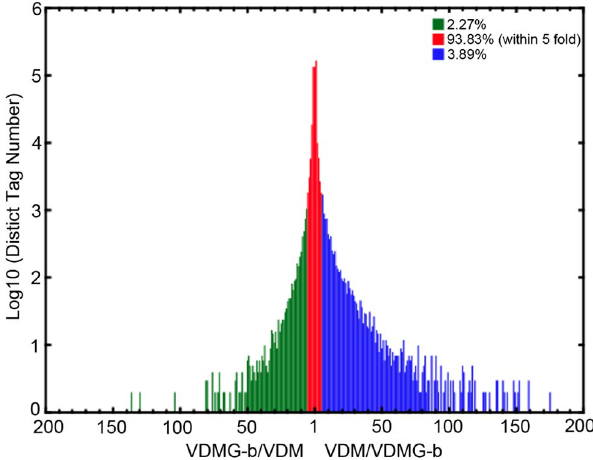
Figure 6. Frequency distribution of differentially expressed tags in the library of germinated Verticillium dahliae micro- sclerotium (VDMG-b) relative to the non-germinated micro- sclerotium library (VDM). The x axis represents the ratio of expression levels between the two libraries and the y axis represents the number of unique tags (log10).